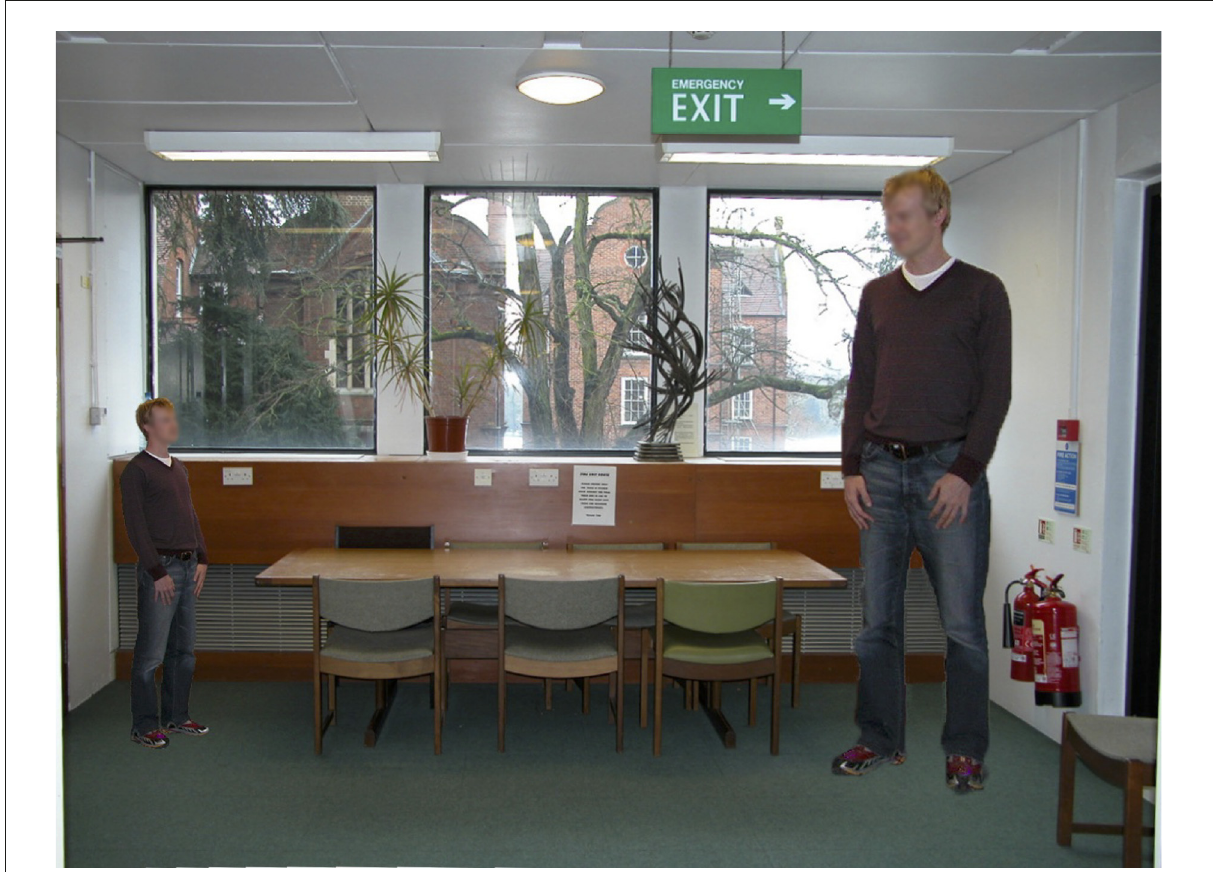
FIGURE3 “Ceci n’est pas une Ames room?” (with apologies to Rene Magritte). This is a photograph of a normal rectangular room onto which I have superimposed the images of two identical but differently-sized figures (from Rogers, 2017a Figure I10–1).